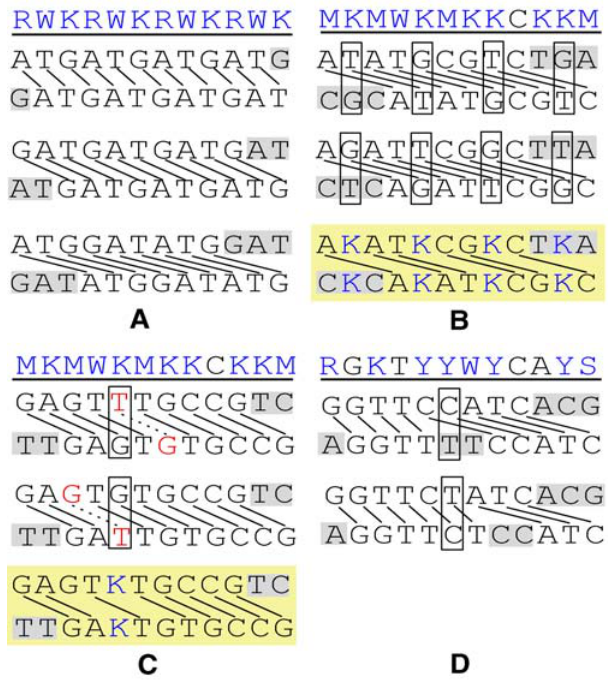
Figure 5. Examples of four main situations in which a mixed sequence fragment can have multiple cooptimal solutions. The fragments are shown on top of each panel, with their aligned optimal solutions and consensuses of these (on a yellow background) shown below. Solid links represent matches and dashed links mismatches, letters on a grey background represent bases with no positional homologs, blue letters represent ambiguous bases, and red letters mismatching bases. Configurations yielding equal maximum scores v in (B), (C), and (D) are boxed. For the meanings of the IUPAC symbols see Figure 1. (A) A fully periodic fragment. Only three of 11 cooptimal solutions with different single phase shifts are shown. The consensus of these solutions is identical to the mixed fragment itself. (B) A fragment containing an ambiguous base (here ‘‘K’’) repeated throughout the length of the fragment at regular intervals coinciding with the magnitude of the phase shift. The corresponding sites remain ambiguous in the consensus. Cooptimal solutions of this type are found mostly among fragments that are short with respect to the indel. (C) A fragment having cooptimal solutions with the same number but different locations of mismatches. Note that mismatches can either represent SNPs or result from basecalling errors. (D) A fragment containing an insertion that can be variably positioned. At one site, both alternative configurations yield maximum v , each with a different phase shift.